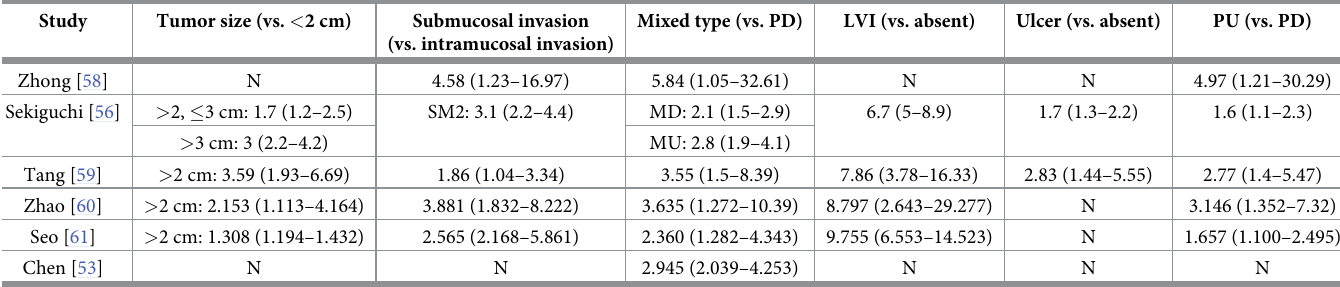
Table 2. Summary of odds ratios with 95% CIs in included studies as risk factors for lymph node metastasis (results of multivariate analysis). Study Tumor size (vs. < 2 cm)